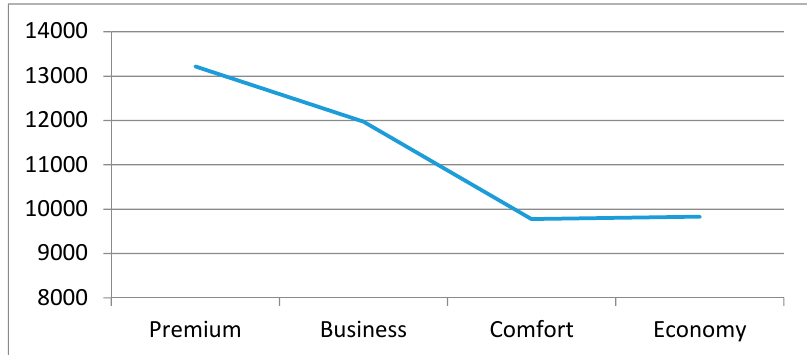
Figure 8. Impact relative (per m 2 ) vs. building comfort level.